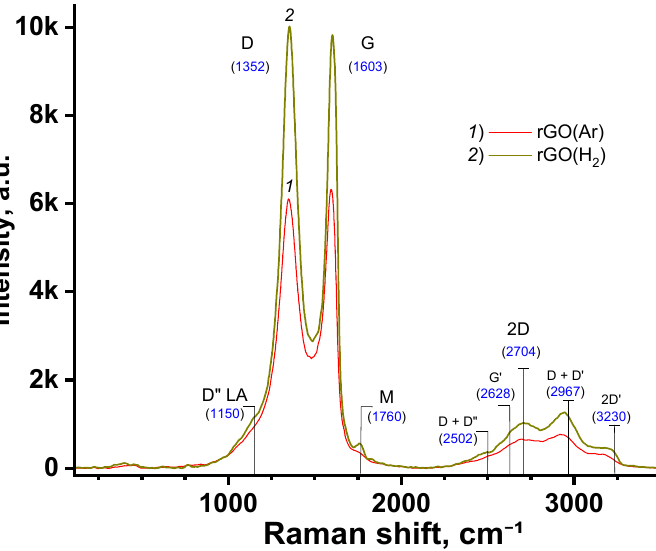
Figure 3. Raman spectra of rGO reduced in an Ar (1) or H ₂ (2) atmosphere. The main peaks are labelled according Ferrari [46] and Ma [20].